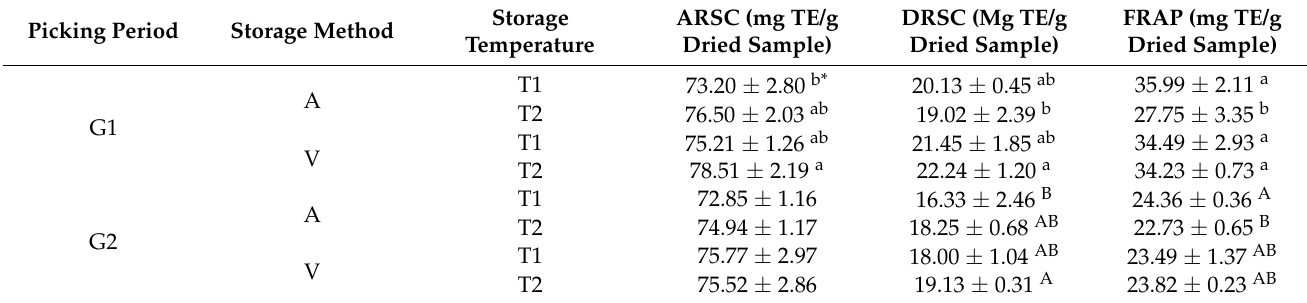
Table 1. Antioxidant capacity of mulberry leaves stored with four different methods in G1 and G2. Picking